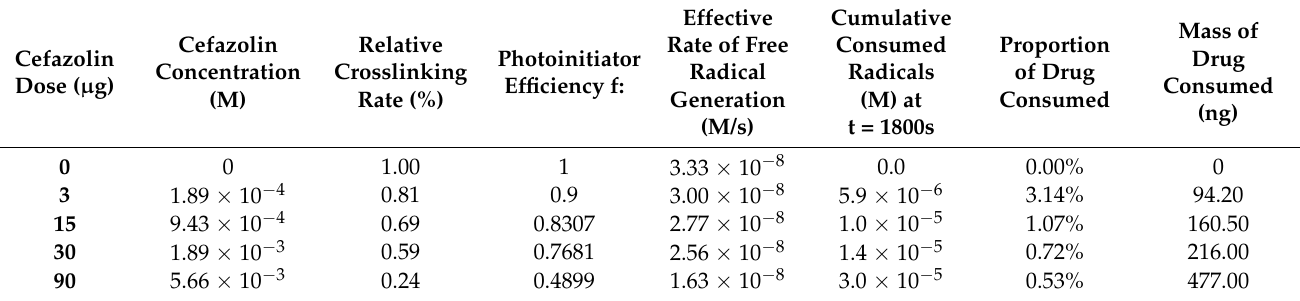
Table 2. Proportion of cefazolin molecules potentially consumed during crosslinking